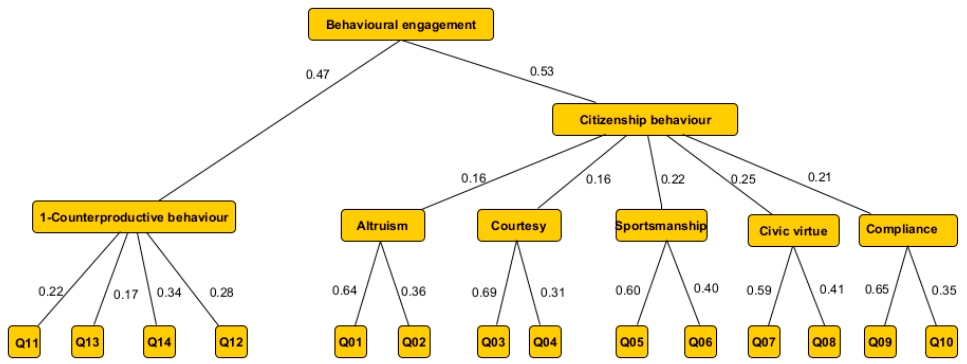
Figure 6. Fuzzy signature of the Hungarian responses.